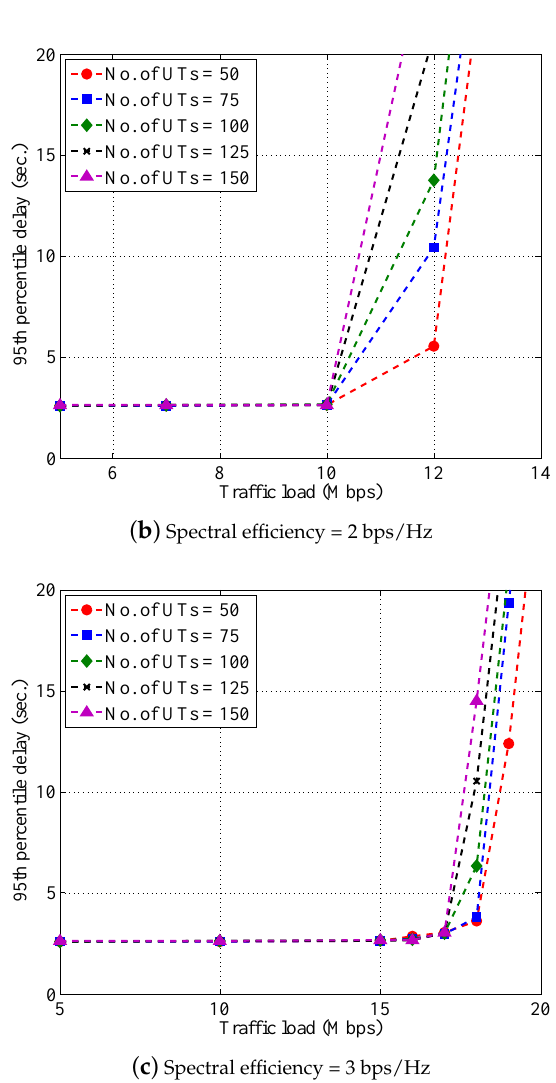
Figure 13. The 95th percentile delay according to the traffic load (Mbps) when the number of UTs varies from 50–150 (VBDC).